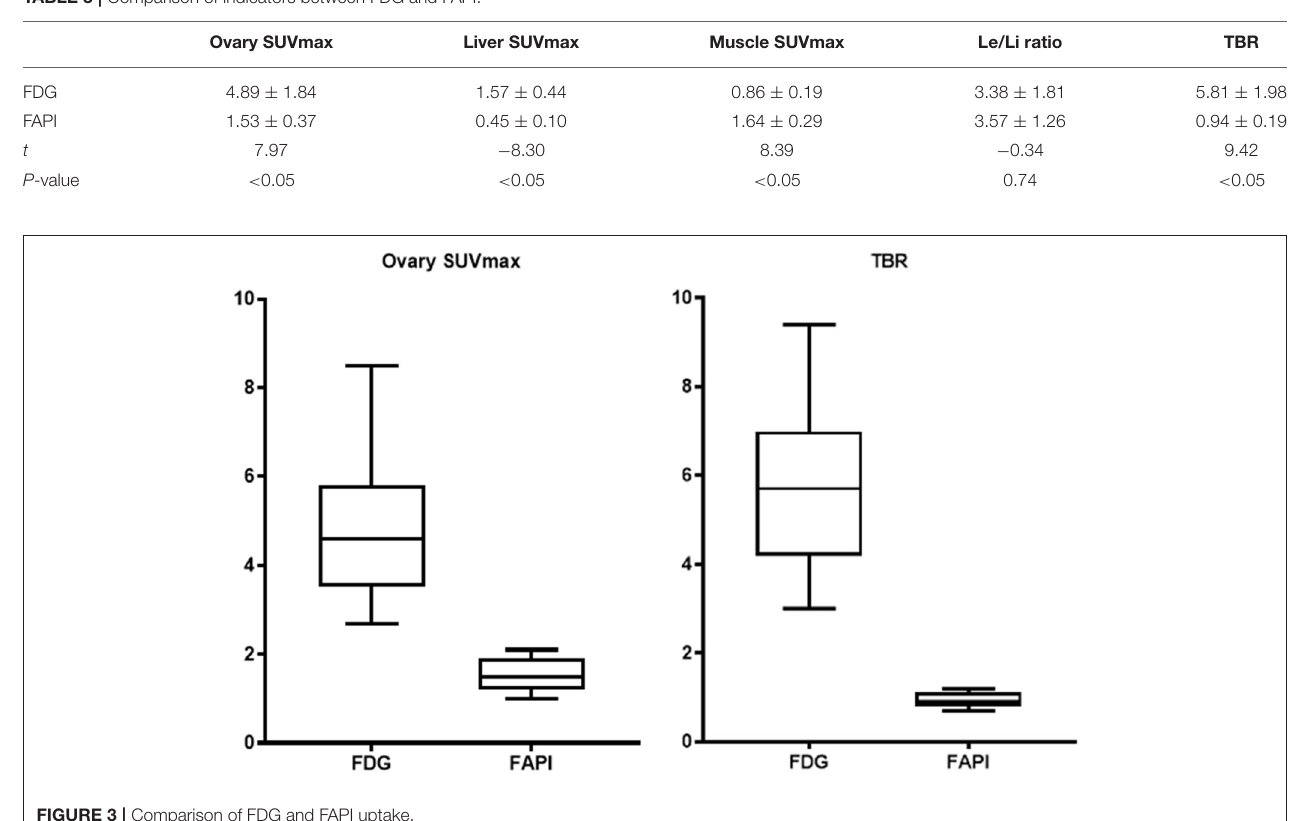
TABLE 3 | Comparison of indicators between FDG and FAPI.